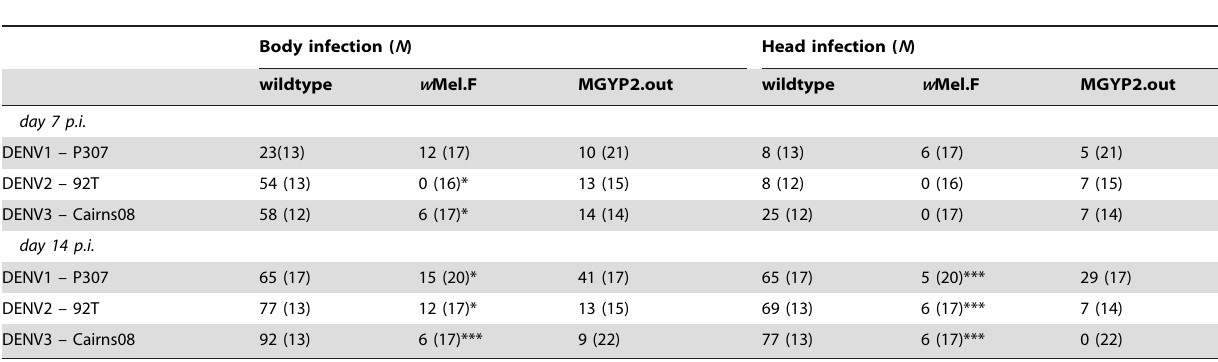
Table 2. Rates of infection (%) for three DENV strains among field ( w Mel.F) and laboratory Wolbachia -infected (MGYP2.out) and